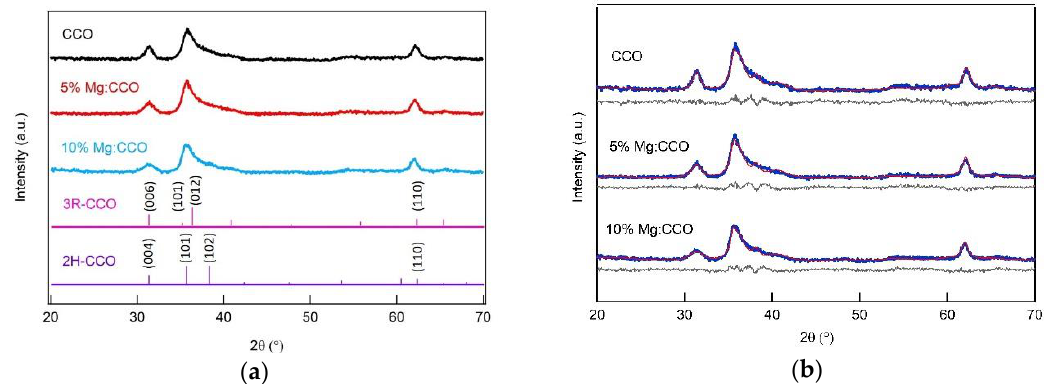
Figure 1. ( a ) X-ray diffraction (XRD) patterns of CuCrO 2 (CCO) (black curve), 5% Mg:CCO (red curve), and 10% Mg:CCO (blue curve) powders. Two CCO polytypes, 3R-CCO (Powder diffraction files (PDF) #39-0247, pink sticks) and 2H-CCO (PDF#89-6743, purple sticks) are detected in all three XRD patterns. Prominent reflections are indexed between 30° to 40°, and ~62.0°. ( b ) Rietveld refinement of XRD patterns. The experimental (blue solid circle), calculated (red curve) and, difference (grey curve) patterns are shown. Structural files for the refinement are 3R-CCO (Crystallography Open Database (COD) No. 8104066) and 2H-CCO (COD No. 8104065). Table 1. Rietveld refinement results for CCO, 5% Mg:CCO, and 10% Mg:CCO. Sample